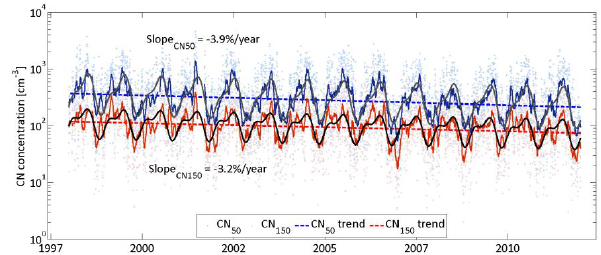
Fig. 9. Same figure as Fig. 9 but for trends in CN 50 and CN 150 Figure 9 Same figure as Fig. 9 but for trends in CN 50 and CN 150 concentrations 1998-2011. 7 concentrations 1998–2011.